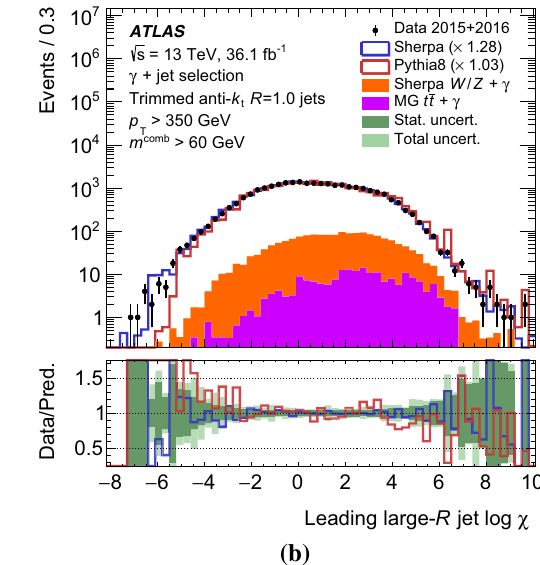
Fig. 29 A comparison of the observed data and MC predictions in the multijet( a )and γ + jet( b )eventsamplesfortheanti- k t R = 1.0trimmed jet spectra of the log χ shower deconstruction discriminant. The data- driven normalisation correction, described in Sect. 6.2.1, is shown in